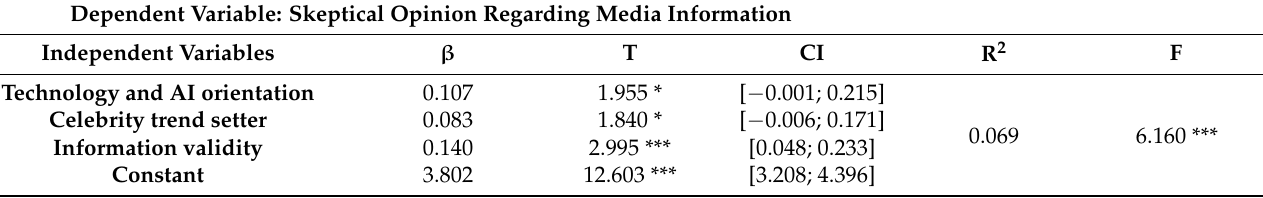
Table 2. The overall regression